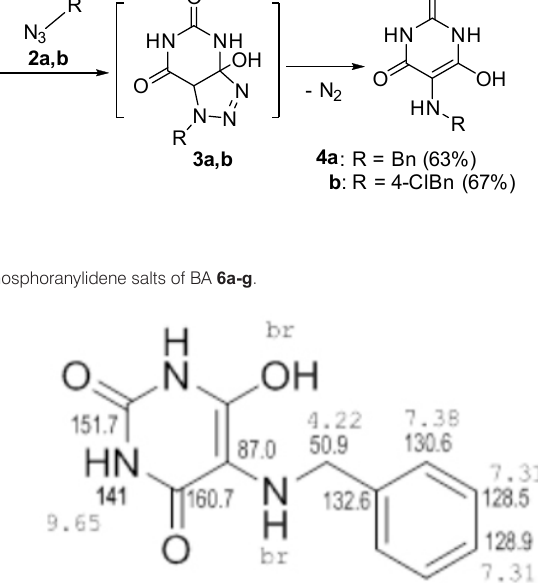
Figure 1. Structure determination for C5-amino barbiturate 4a with gHMBC